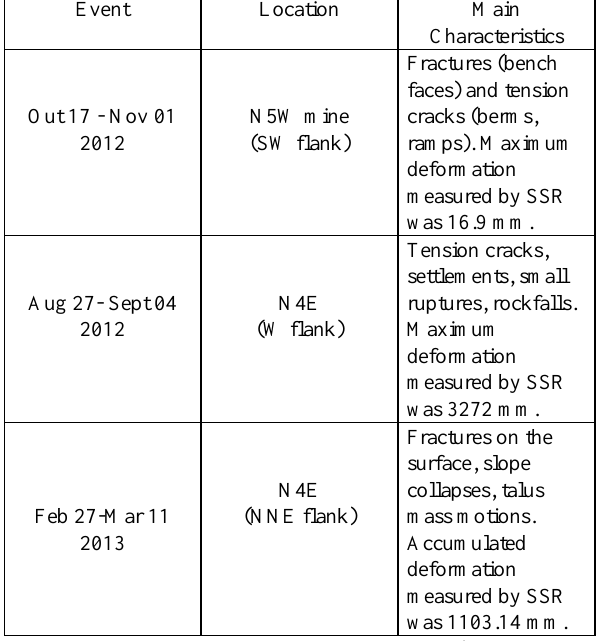
Table 1. Slope instabilities events in the area (sources: Vale 2012 a, b, Vale